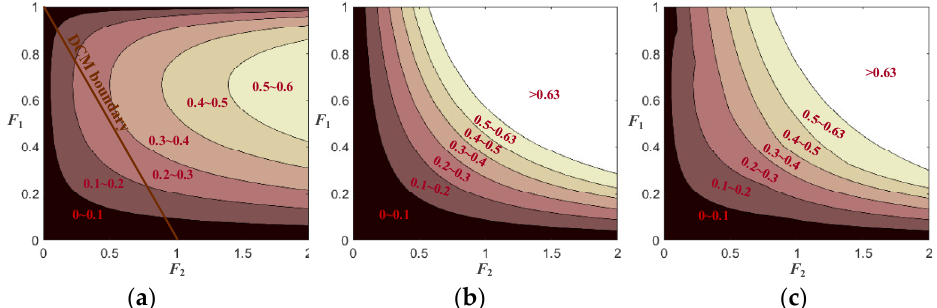
Figure 9. Normalized inductor current peak value (i.e., i L ,pk /( v out T / L )) with different controls. ( a ) VoT control to achieve DCM; ( b ) CoT control to achieve CRM; ( c ) TACC control to achieve mixed DCM/CRM/CCM.